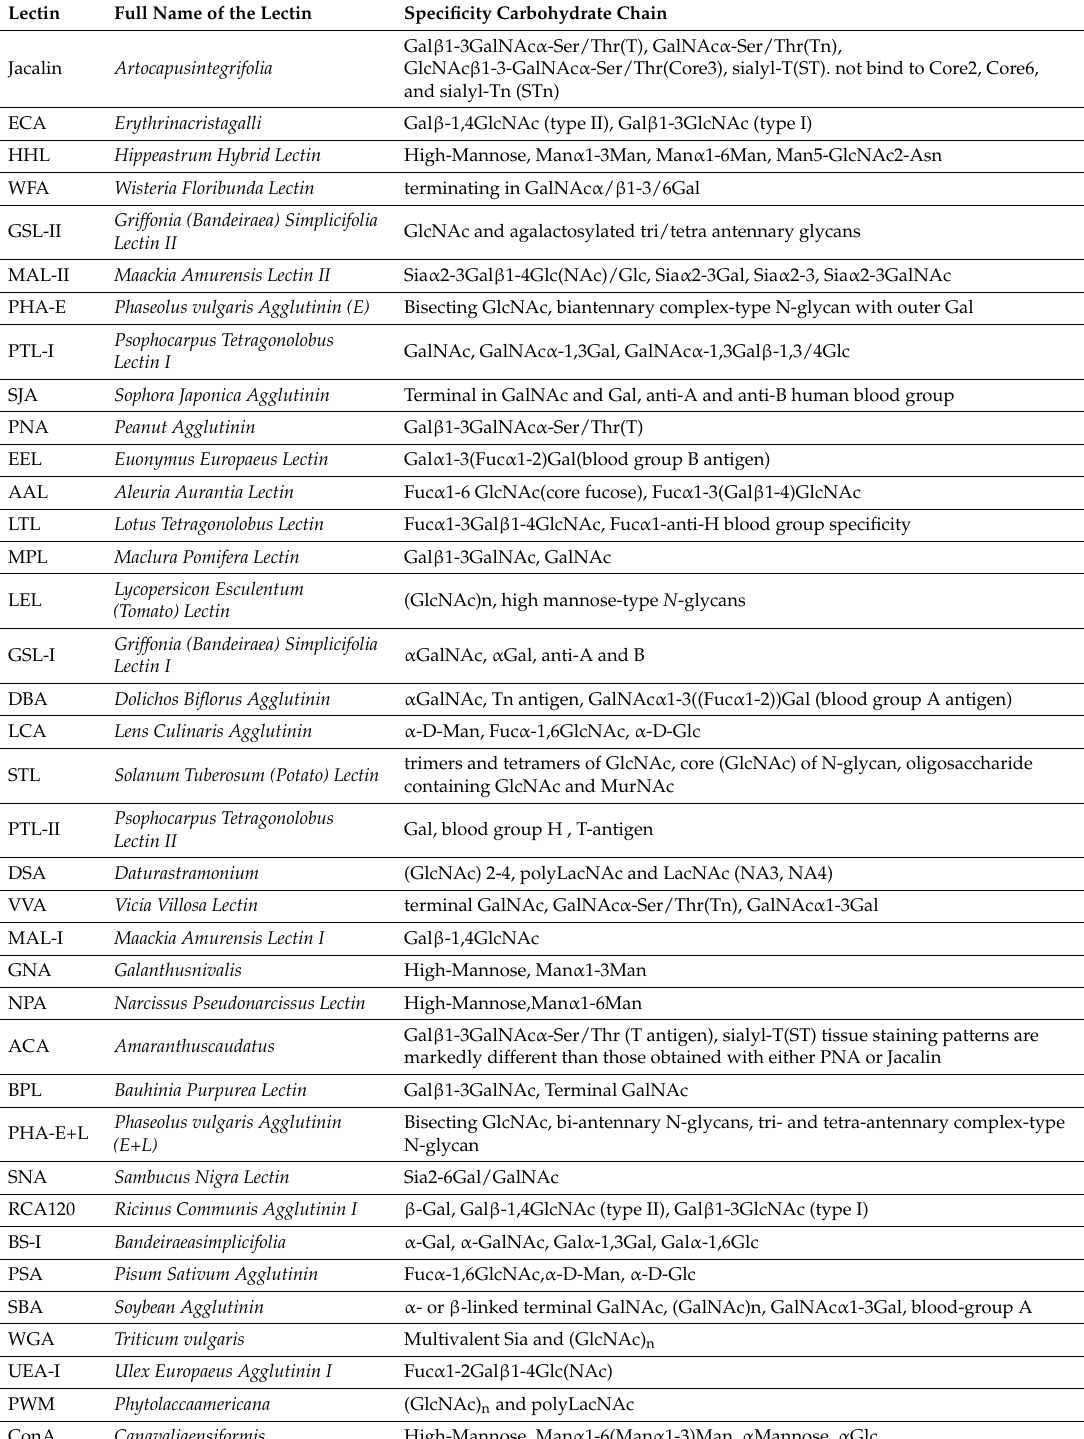
Table 1. The structures of the carbohydrate chains recognized especially by